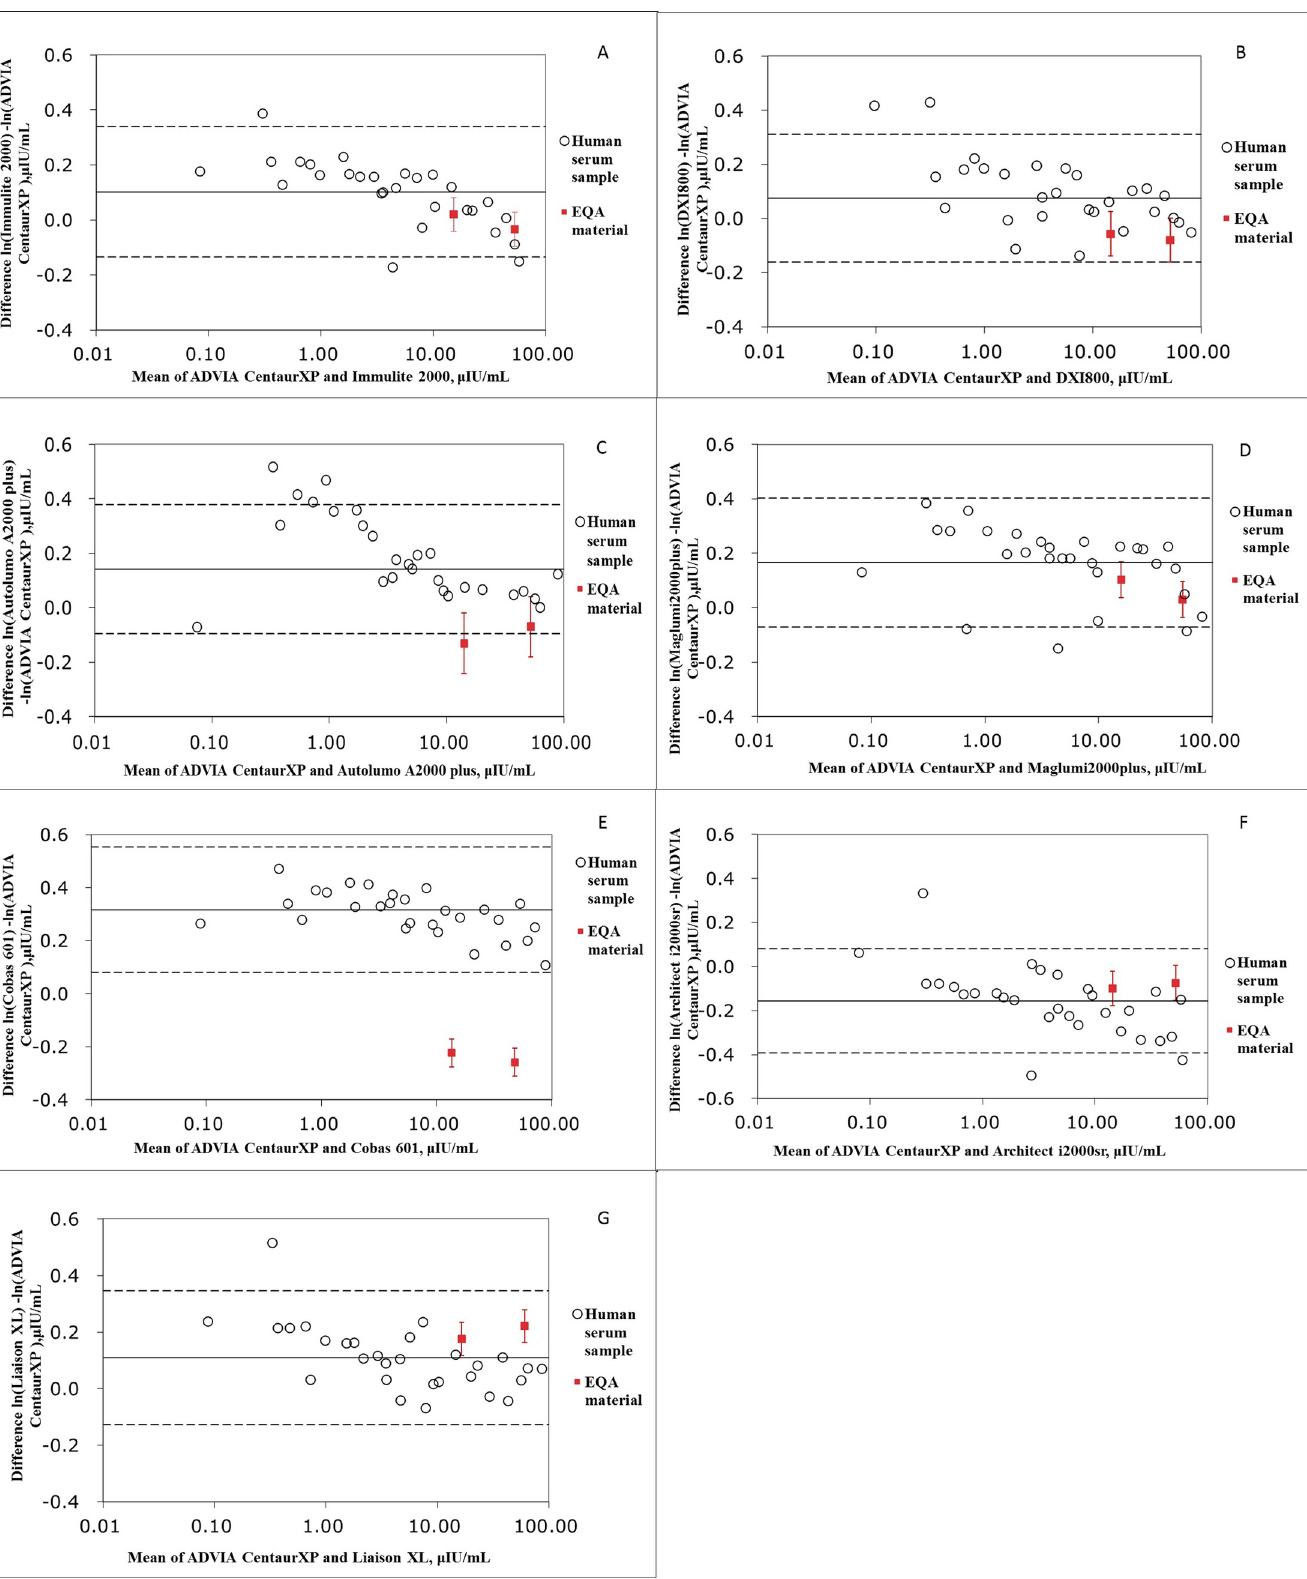
Fig 4. Commutability of National Center for Clinical Laboratories external quality assessment (EQA) materials among the eight assessed thyroid-stimulating hormone (TSH) instrument platforms based on IFCC approach.